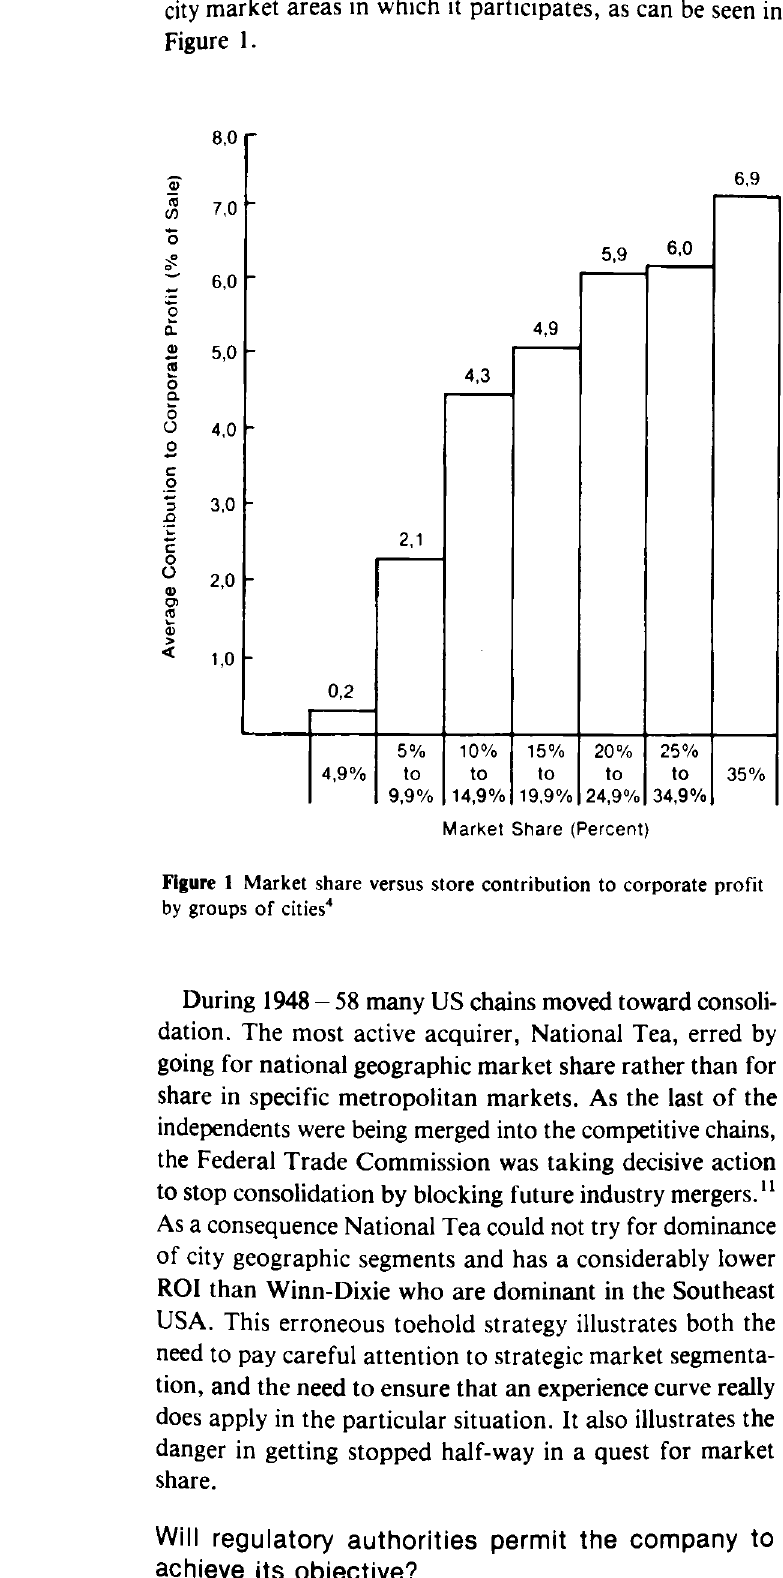
Figure 1 Market share versus store contribution to corporate profit by groups of cities